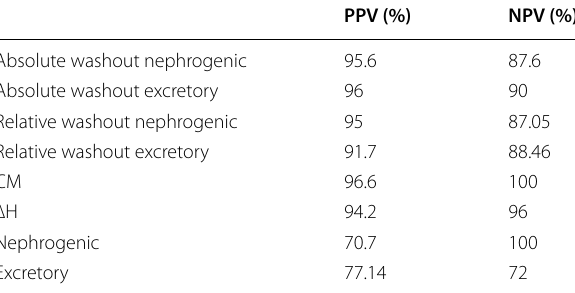
Table 7 Predictive value of CT wash out levels for CUTOFF points (diagnostic to CCRRC&ChrRCC) PPV (%) NPV (%) Absolute washout